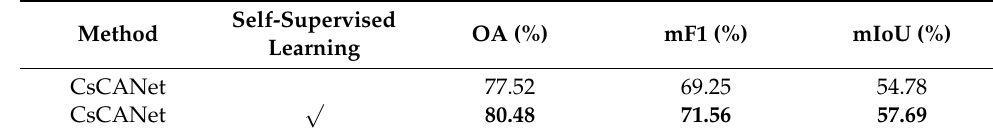
Table 7. Performance comparisons of CsCANet with different improvement strategies in evaluation metrics. The best results are highlighted in bold.